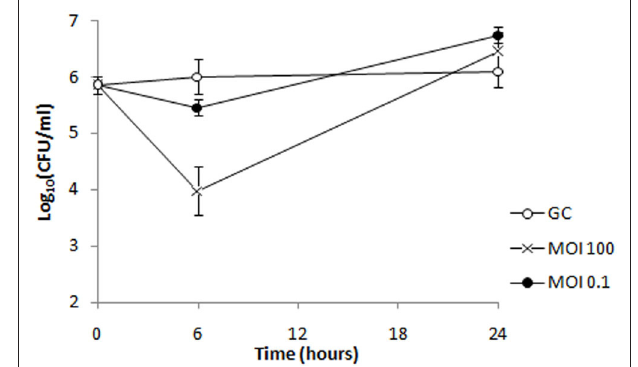
FIGURE 9 | Bacterial cell counts after treatment of biofilm formed by strain 6077/12 with bacteriophage ISTD. A reduction of viable cell count of 0.6 and 2 log units was observed 6h after treatment of biofilm with phage ISTD at MOI 0.1 and MOI 100, respectively, whereas after 24h, no difference in CFU numbers was observed between treated samples and untreated control. GC, growth control without